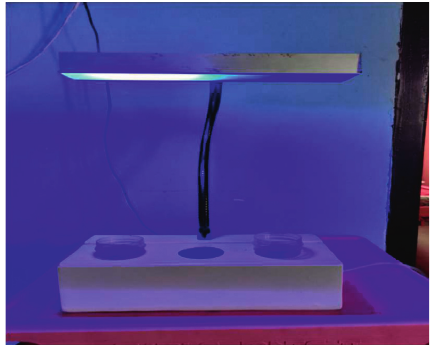
Figure 27: LED system with blue (450 nm) LED ON.